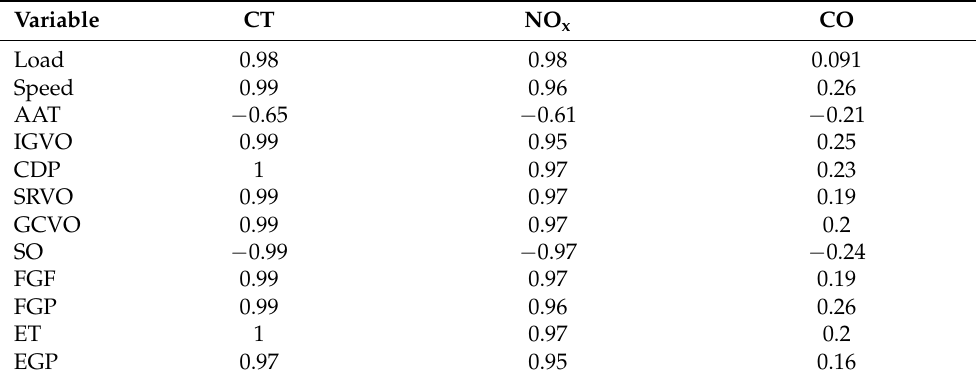
Table 3. Correlation of input and output